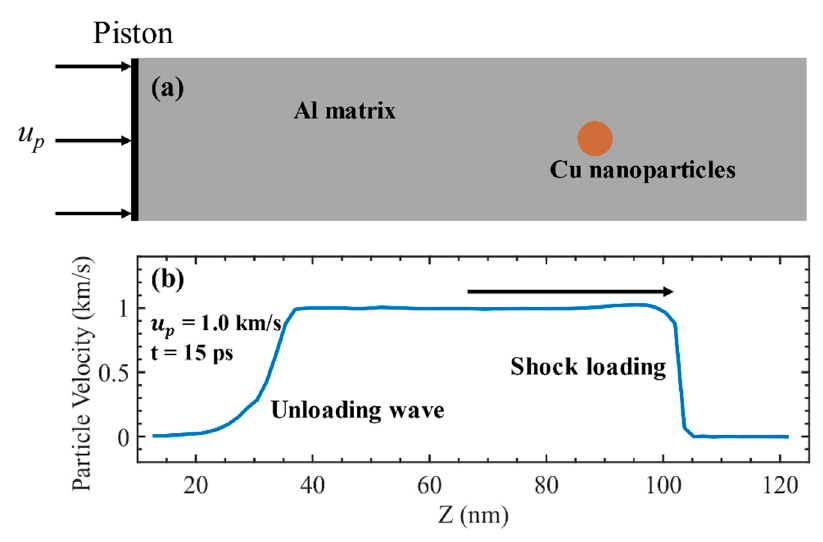
Figure 1. ( a ) Initial configuration of the simulation system. The matrix is single crystal Al and the spherical inclusion is single crystal Cu. ( b ) The loading profile at u p = 1.0 km/s and t = 15